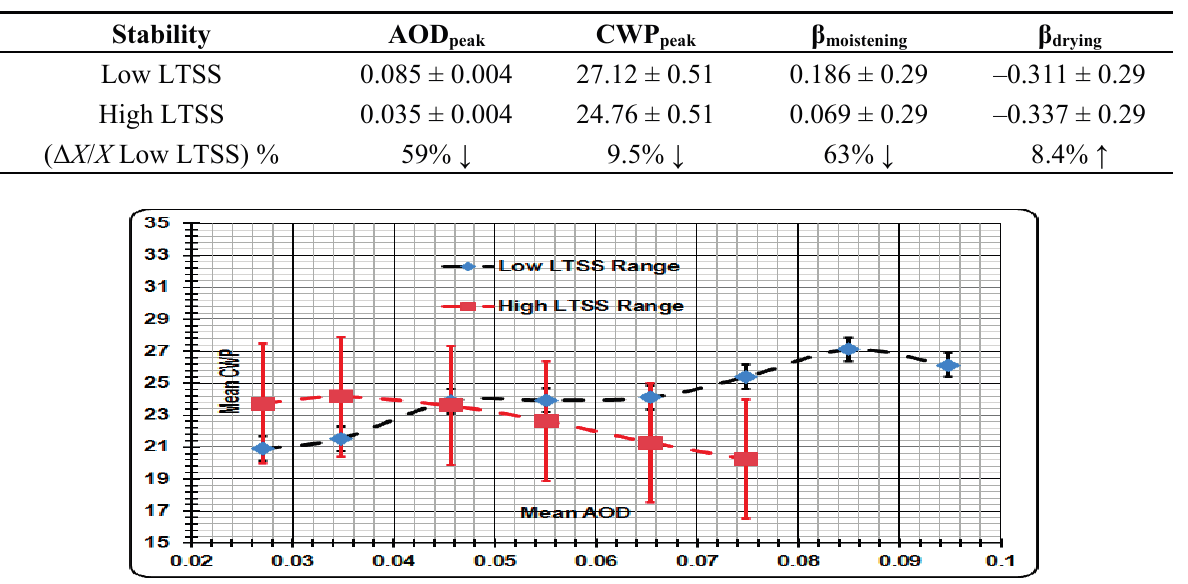
Figure 16. Response of cloud water path (CWP) to increasing aerosol optical depth (AOD) for low (unstable atmospheric condition) and high (stable atmospheric condition) lower tropospheric static stability (LTSS) for